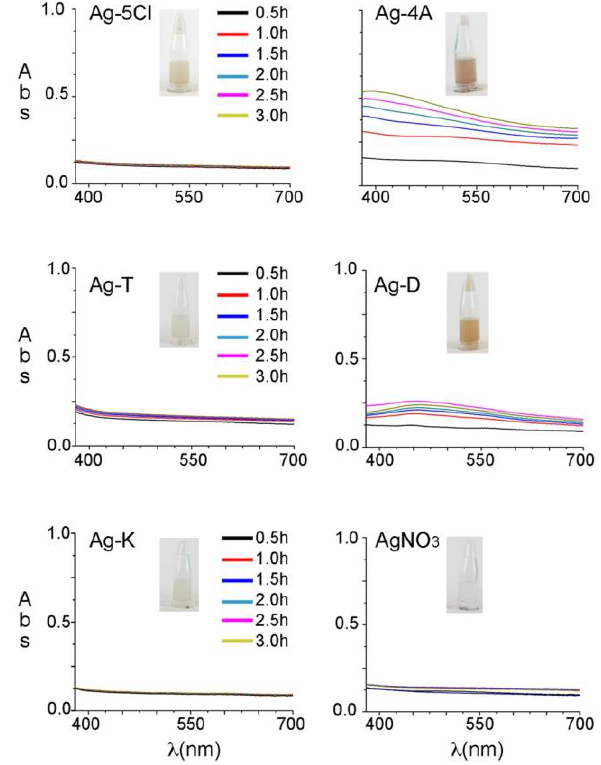
Figure 2. Absorption spectra of the silver solutions over time. Samples were irradiated at 365 nm for 3 h.